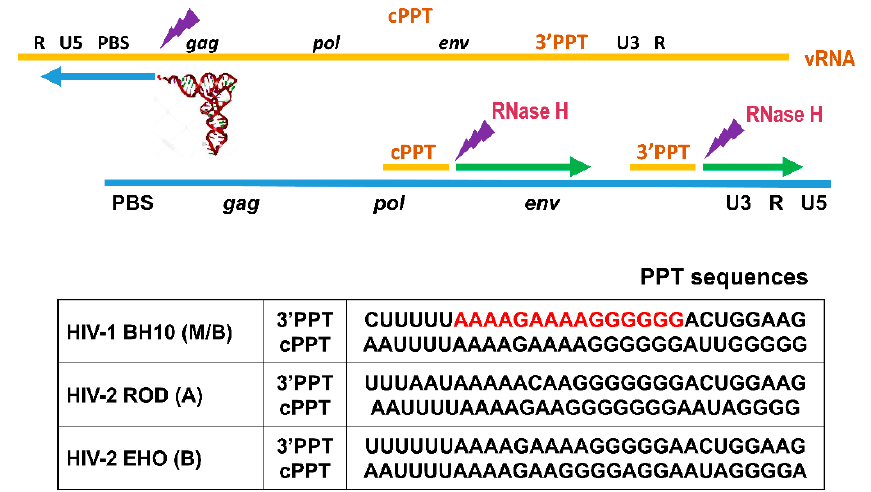
Figure 1. HIV reverse transcription and PPT sequences. The upper panel shows the initiation of reverse transcription with the viral RNA (vRNA) in orange, and the minus-strand DNA in blue. The relative location of viral genes ( gag , pol and env ), and relevant sequences (R, U5, PBS, cPPT, 3 ′ PPT and U3) are shown above the viral RNA. The plus-strand DNA strand is shown in green. Polypurine tracts (cPPT and 3 ′ PPT) are used as primers and lightning symbols indicate RNase H cleavage sites. The lower panel shows PPT sequences of HIV-1 BH10 , HIV-2 ROD and HIV-2 EHO , taken from GenBank accession numbers AH002345.2, X05291 and U27200, respectively. The 3 ′ PPT of HIV-1 BH10 is highlighted in red.